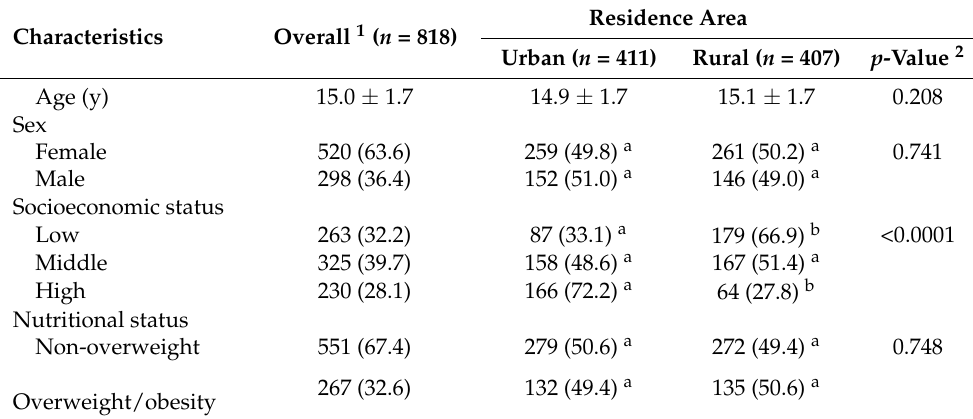
Table 1. General characteristics of Costa Rican adolescents, according to residence area.